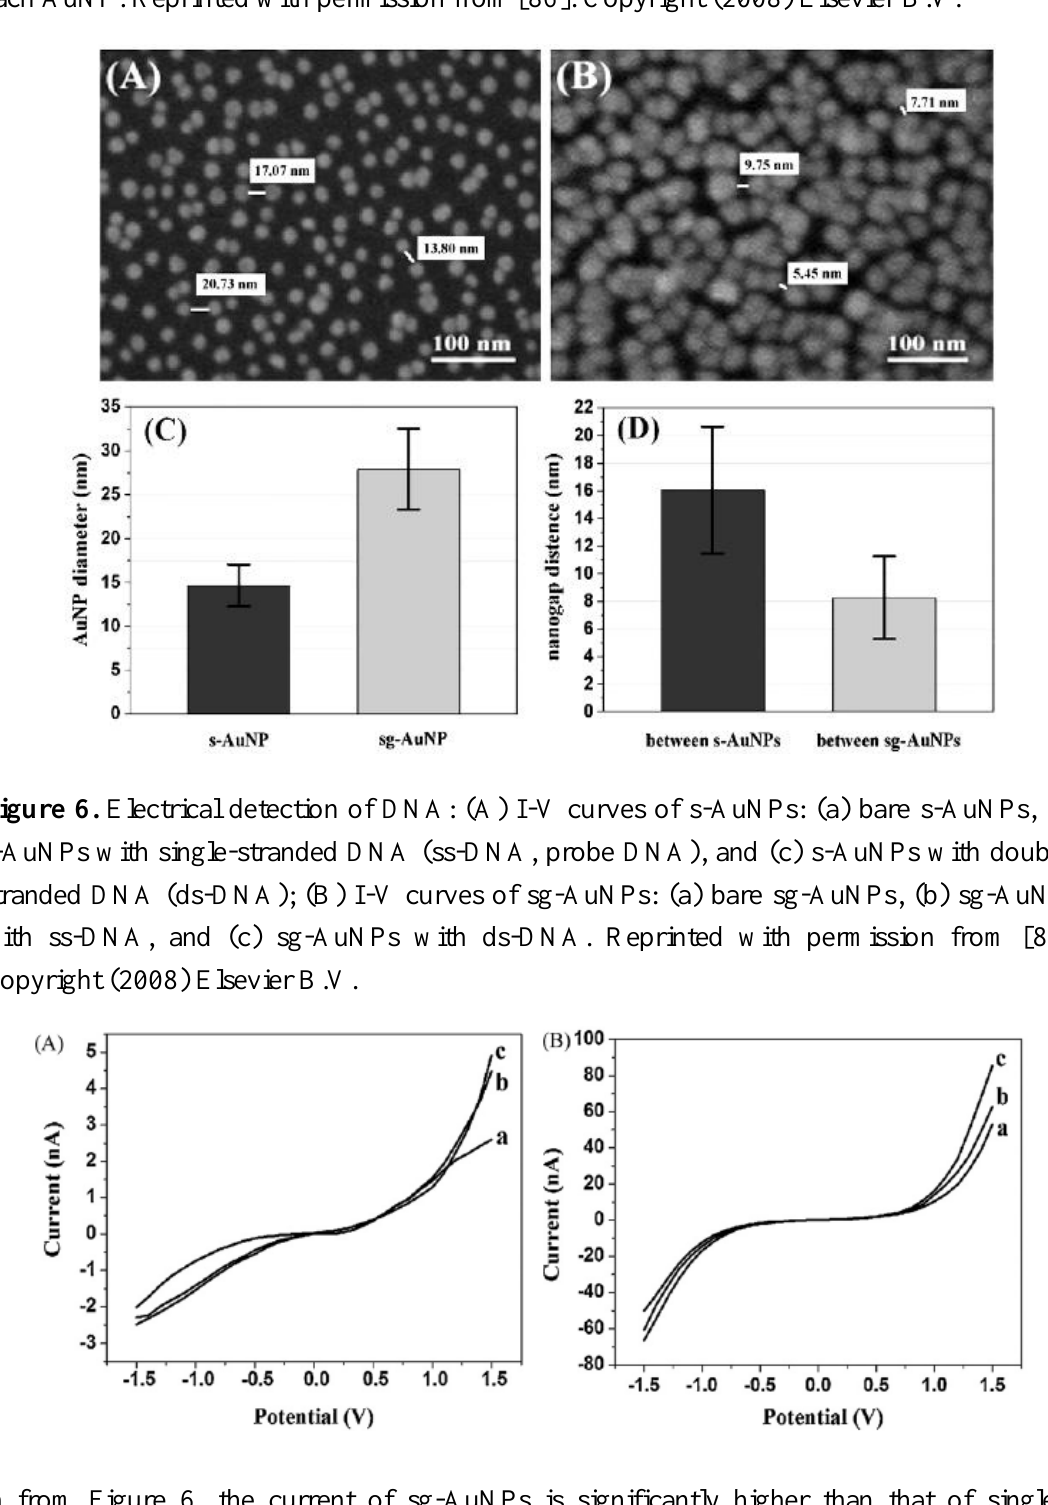
Figure 5. SEM images of AuNPs and the calculated distance between them: (A) single- layered AuNPs (s-AuNPs) between electrodes before growth; (B) high-magnification view of in situ seed-assisted growing (sg-AuNPs) between electrodes after 2 min growth; (C) the nanoparticle diameters of s-AuNPs and sg-AuNPs; (D) the distance of nanogap between each AuNP. Reprinted with permission from [86]. Copyright (2008) Elsevier B.V.